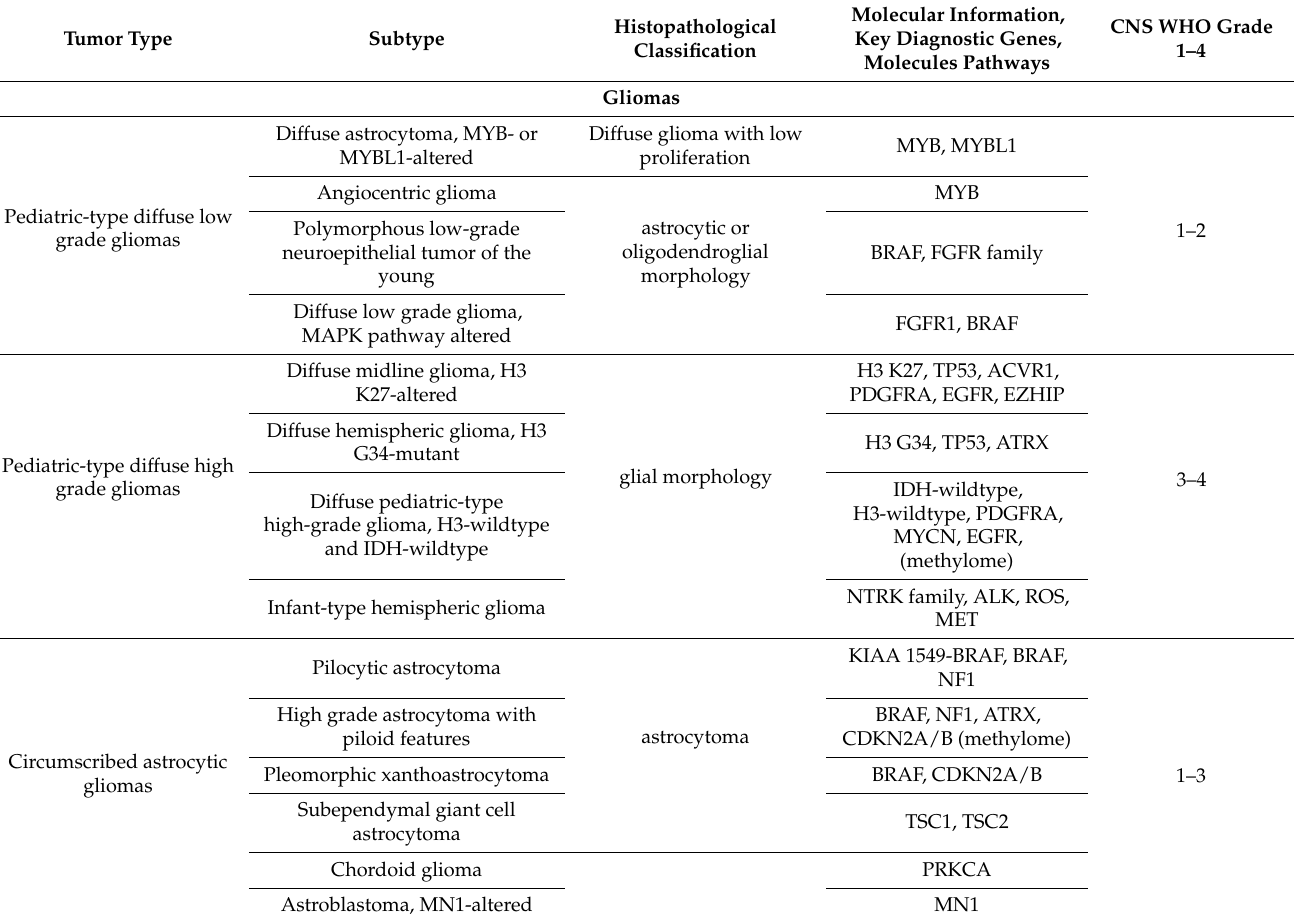
Table 1. Tumor subgroups (extract and simplification) according to the 5th WHO classification with genes/molecular profiles [4,7]. By permission of Oxford University